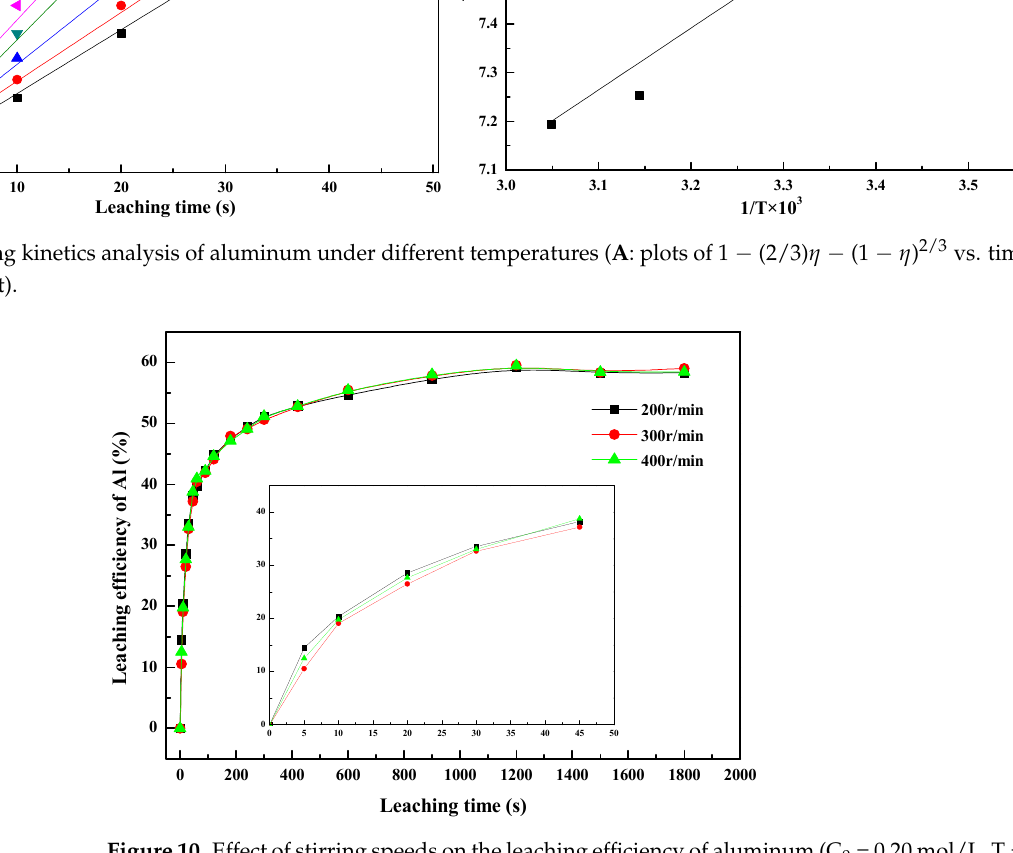
Figure 10. Effect of stirring speeds on the leaching efficiency of aluminum (C 0 = 0.20 mol/L, T = 25 °C, stirring speeds 400 r/min).